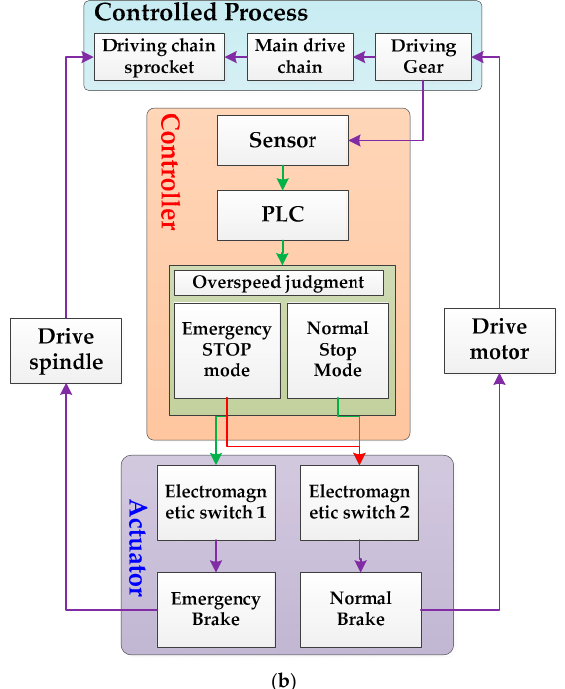
Figure 10. Control structure of escalator operation in two levels: ( a ) Control structure of escalator operation in Level 1, ( b ) Control Structure of the braking system in Level 2.